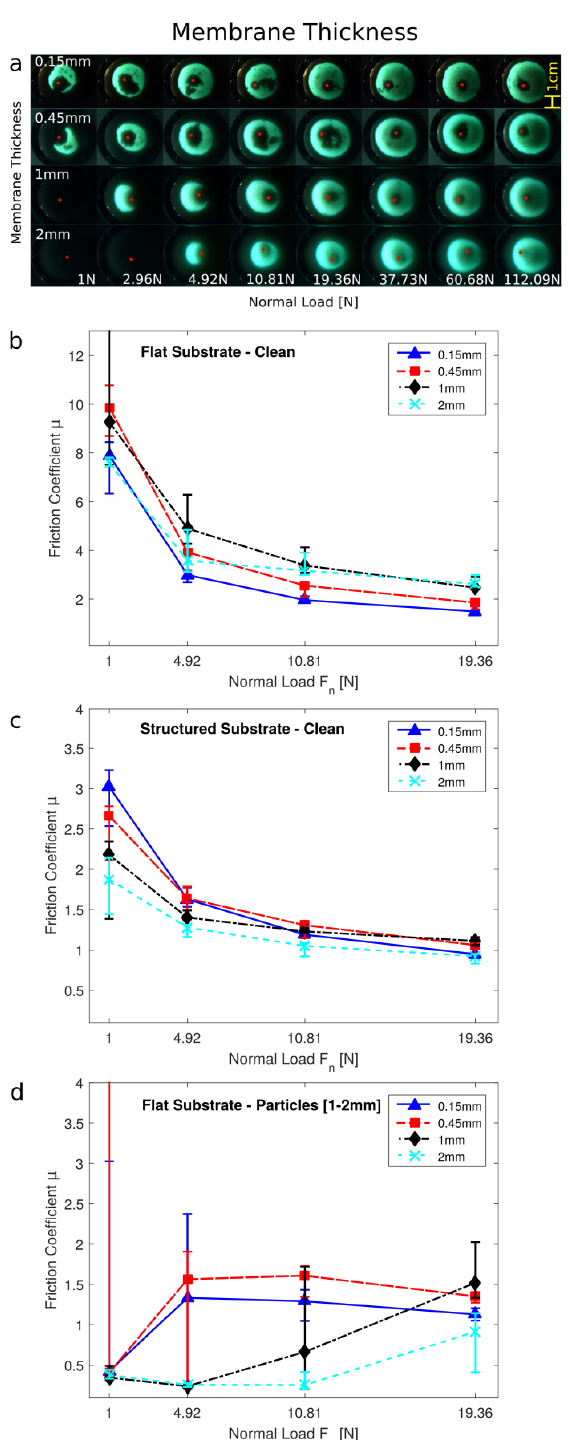
Figure 4. Variation of the membrane thickness of the granular friction pad. ( a ). Visualization of the contact area on a glass sphere and smooth glass substrate. ( b – d ). Friction coefficient of the samples at different normal loads F n : ( b ) on a smooth substrate, ( c ) on a rough/structured substrate, ( d ) on a smooth substrate contaminated by 1–2 mm large particles.